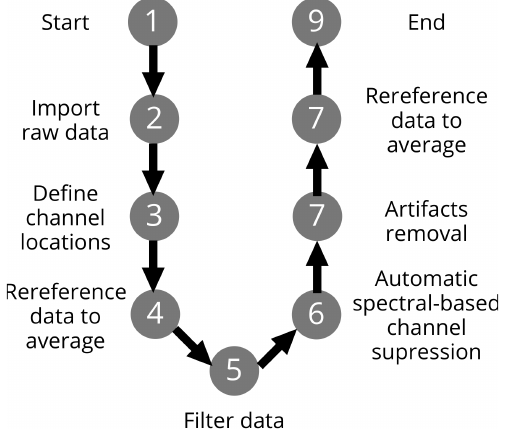
Figure 6. The illustration of the offline preprocessing